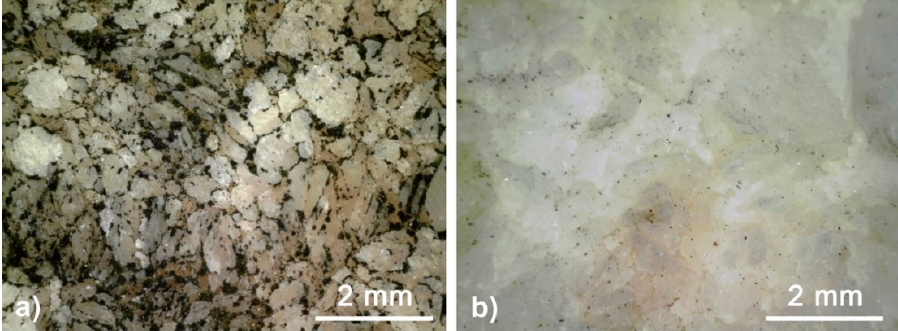
Figure 2. On-site digital microscopy documentation of the ( a ) untreated and ( b ) treated stone surface at the same magnification.